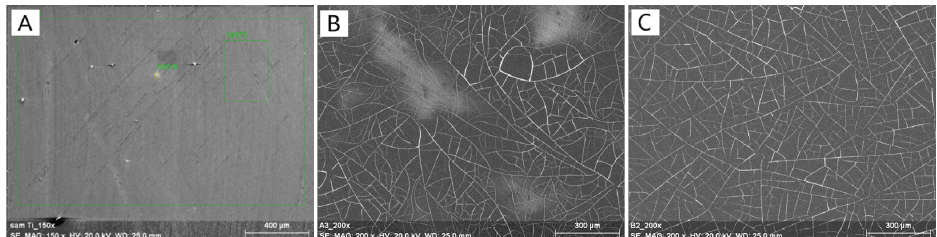
Figure 1. Scanning electron microscopy images depicted the morphology of the tannic acid-modified surfaces of the ( A ) control titanium plate without a layer of tannic acid, with lines showing the lines left during polishing; the 150× ( B ) titanium plate with embedded 5% tannic acid; and the ( C ) titanium plate with 10% tannic acid embedded (200×).